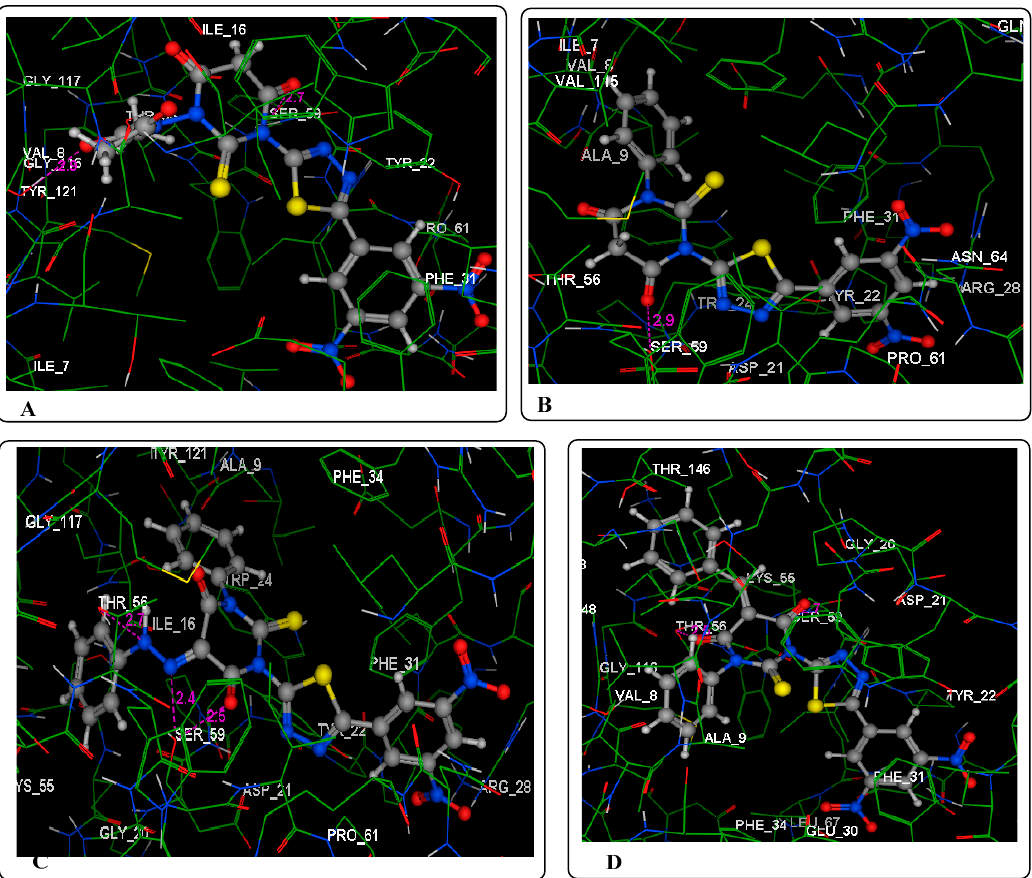
Figure 6. Three-dimensional representation of the interactions of compounds 10 ( A ), 13 ( B ), 14 ( C ), and 15 ( D ) with the DHFR enzyme pocket amino acids.